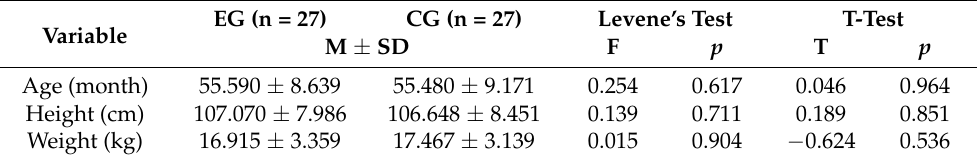
Table 3. Female subject variance homogeneity